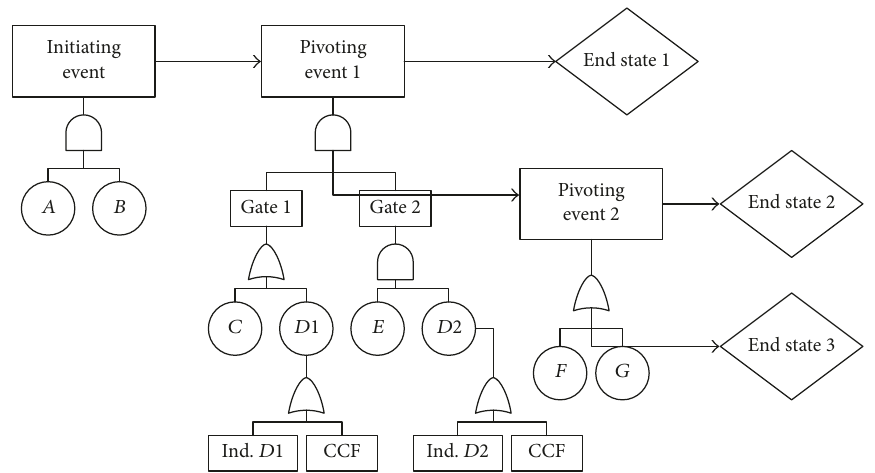
Figure 6: Example of ESD underlying fault